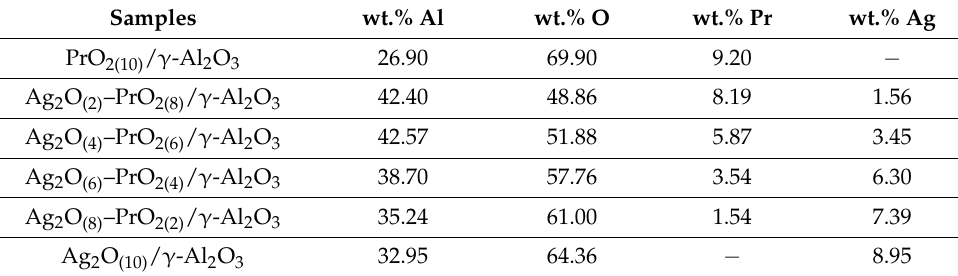
Table 2. Elemental compositions (wt.%) from EDX analysis of